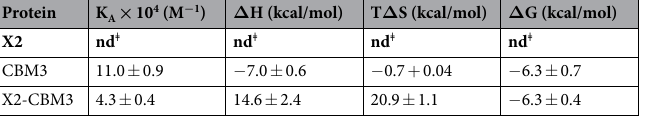
Table 2. Binding affinity constants (K A ) and thermodynamic properties of independent modules and xyloglucan interactions * . * ITC thermograms are available as supplementary information [see Supplementary Fig. S3]. ǂ Could not be determined (explained in the